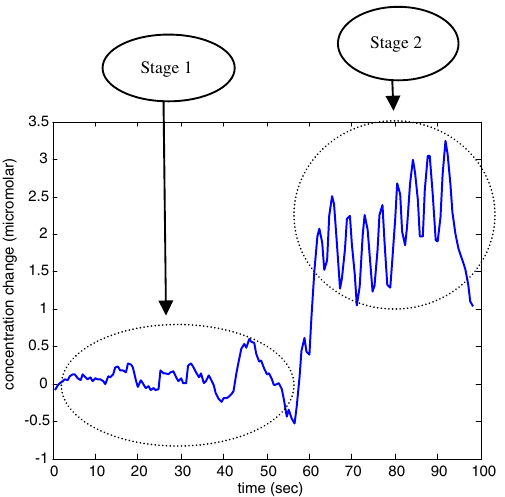
Fig. 2. Example of a typical fNIR signal with rest and head motion stages (stage 1 and stage 2,